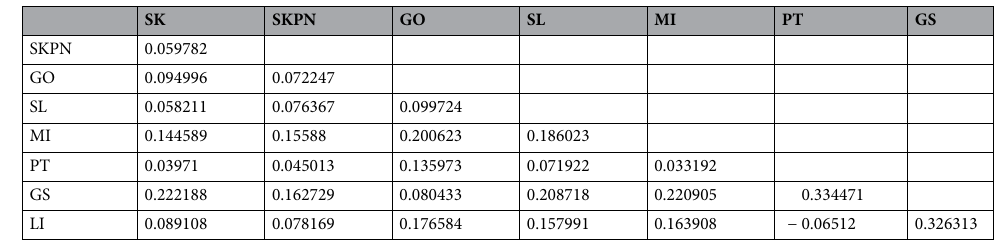
Table 1. Pairwise F ST values for all pairs of contemporary populations based on individuals of D. cucculata ; ENA correction applied; significance level = 0.05; all values significant. Samples are ordered as follows: three control lakes (SK, SKPN, GO), two transitional heated lakes (SL, MI) and three heated lakes (PT, GS, LI).